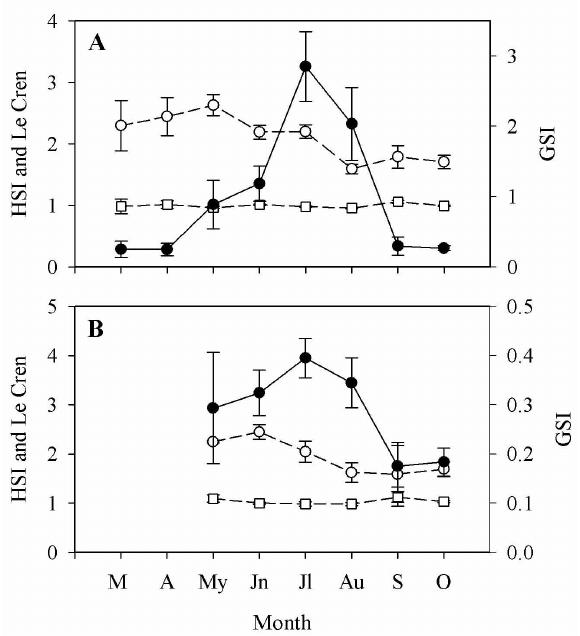
Fig . 4. – Monthly mean ( ± SE) gonadosomatic index (GSI) ( l ), hepatosomatic index (HSI) (  ) and Le Cren index (  ) for females (A) and males (B) of Epinephelus marginatus .